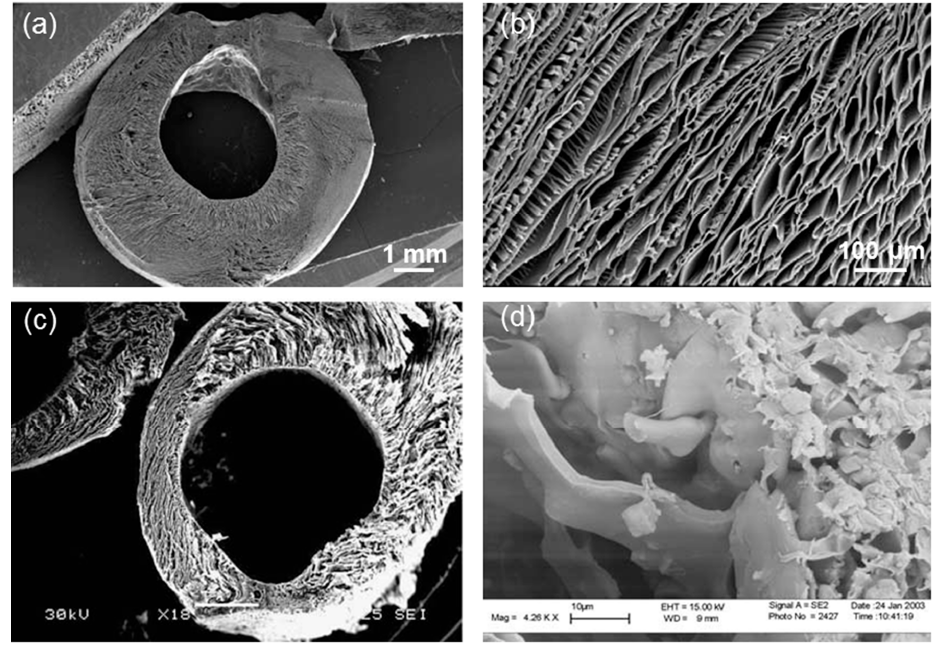
Figure 6. Tubular PLGA/45S5 Bioglass ® composite constructs: SEM micrographs showing: a radial section of an uncoated PLGA tube ( a ); and a detail of the cross-section ( b ); and the radial section of the composite tubular foam ( c ); and detail of the Bioglass ® particles on a fracture surface ( d ). Images from Boccaccini et al. [86] © Elsevier.